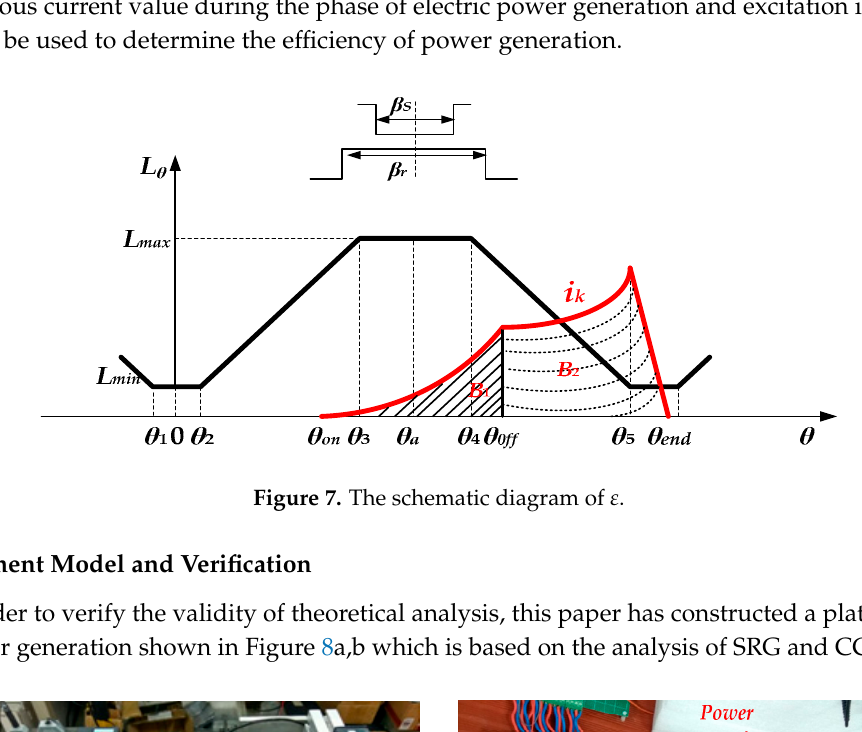
Figure 8. The photograph of the experimental platform of SRG power generation. ( a ) Experiment platform of SRG; ( b ) control circuits and the power converter.